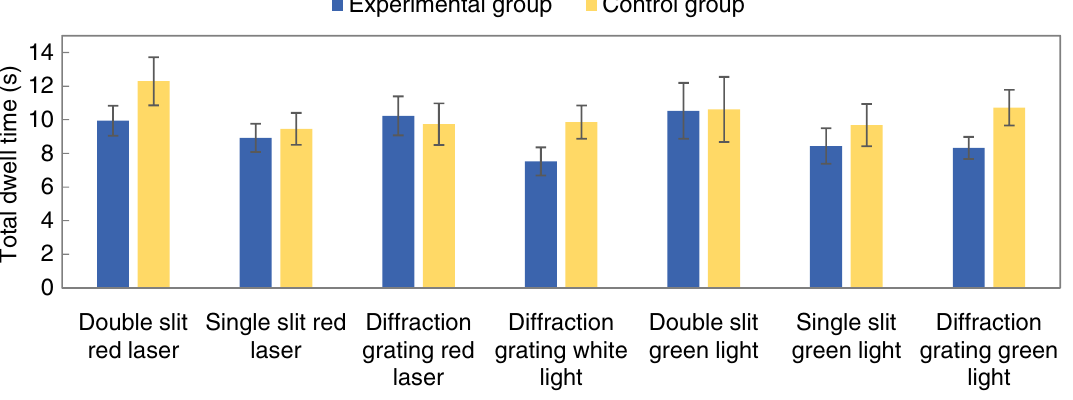
FIG. 5. The total dwell time of students in the experimental and control group on all seven questions. The error bars represent 1 standard error of the mean (SEM).